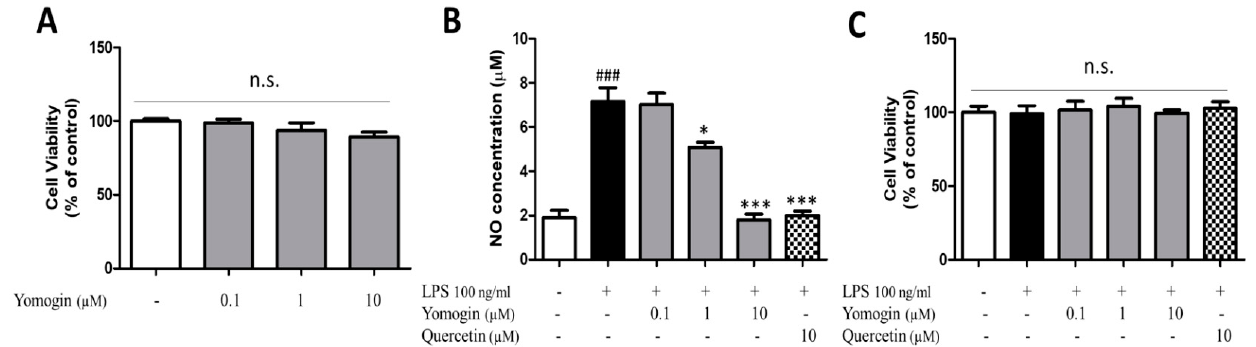
Figure 2. Effects of yomogin on cell viability and NO production in LPS-stimulated BV2 microglial cells. Cells were incubated with yomogin for 24 h without ( A ) or with ( C ) LPS treatment for the last 23 h ( n = 6 per group). The supernatant containing NO was determined by Griess reagent colorimetric reaction ( B ) ( n = 6 per group). Quercetin was used as a positive control. Data were analyzed by one-way ANOVA, followed by Tukey’s post hoc test. ### p < 0.001 compared to the control group; * p < 0.05 and *** p < 0.001 compared to the LPS only treated group. Values are expressed as mean ±